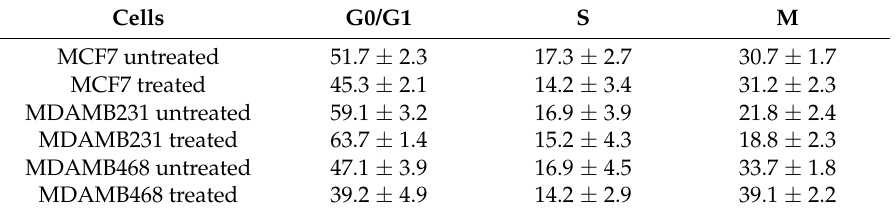
Table 3. Cell percentages in the cell cycle phases (gap 0 (G0), gap1 (G1), synthesis (S), gap2 (G2) and mitosis (M) phases) expressed as mean ± standard deviation by the Muse Cell cycle assay in MCF-7, MDA-MB231 and MDA-MB468 cells after treatment with IC 50 concentrations obtained after 48 h. Untreated cells were used as control.